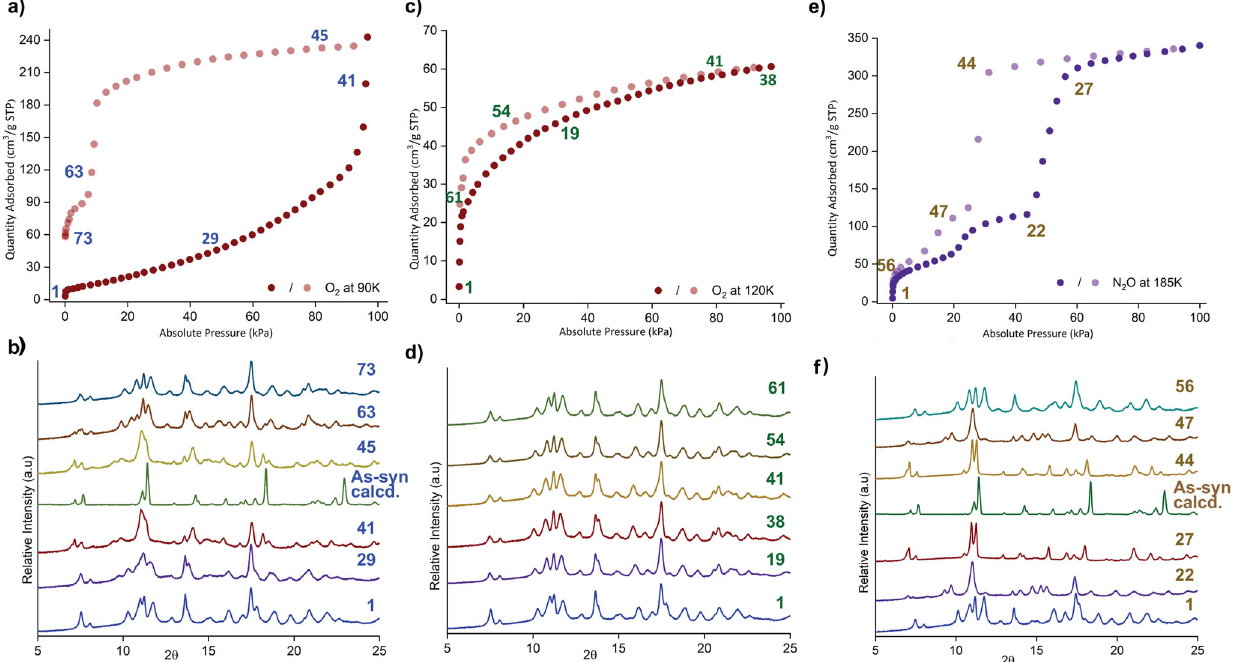
Fig. 4 In-situ PXRD measurements were measured upon adsorption and desorption. a , b Several selected PXRD patterns were plotted for O 2 sorption at 90 K, showing reversible 1 β ⊃ empty to 1 α ⊃ O 2 transformations. c , d similarly, in-situ PXRD upon O 2 sorption at 120 K indicates that 1 β ⊃ empty to 1 β ⊃ O 2 with some shift in the peaks, corresponds to structural distortion in linkers (Supplementary Fig. 30). e , f N 2 O sorption induces two-step gate opening, 1 β ⊃ empty to intermediate (1 γ ⊃ N 2 O) and then to 1 α ⊃ N 2 O phase in a reversible